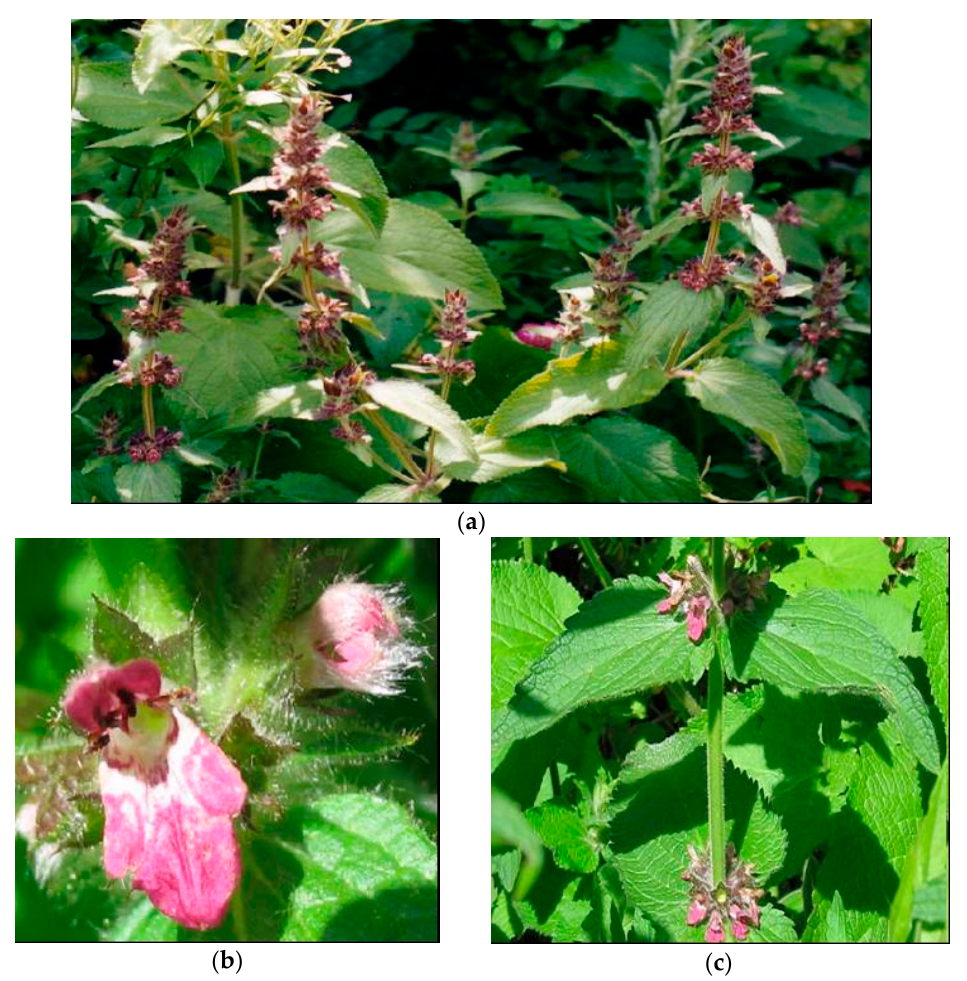
Figure 1. Stachys alpina L . ( a ) plant in flowering stage; ( b ) detail of the flower; ( c ) detail of leaf.